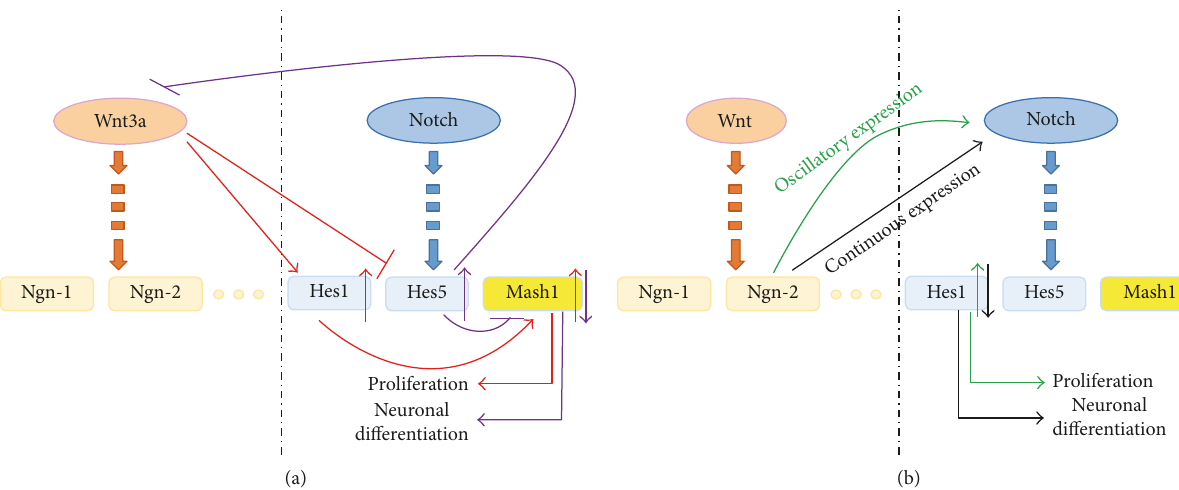
Figure 3: The interaction between the Wnt and the Notch signaling pathways. (a) Wnt3a could upregulate the expression of the downstream target gene Hes1 of the Notch signaling pathway and inhibit the expression of Hes5 and then induce the proliferation of NSCs (the red arrows). The overexpression of Hes5 inhibited the Wnt signaling pathway, downregulated Mash1 , and induced neuronal di ff erentiation (the purple arrows). (b) The oscillatory expression of Ngn-2 could activate the Notch signaling pathway so that Hes1 was upregulated to promote the self-renewal of NSCs (the green arrows). The continuous expression of Ngn-2 inhibited the expression of Hes1 and promoted the di ff erentiation of NSCs into neurons (the black